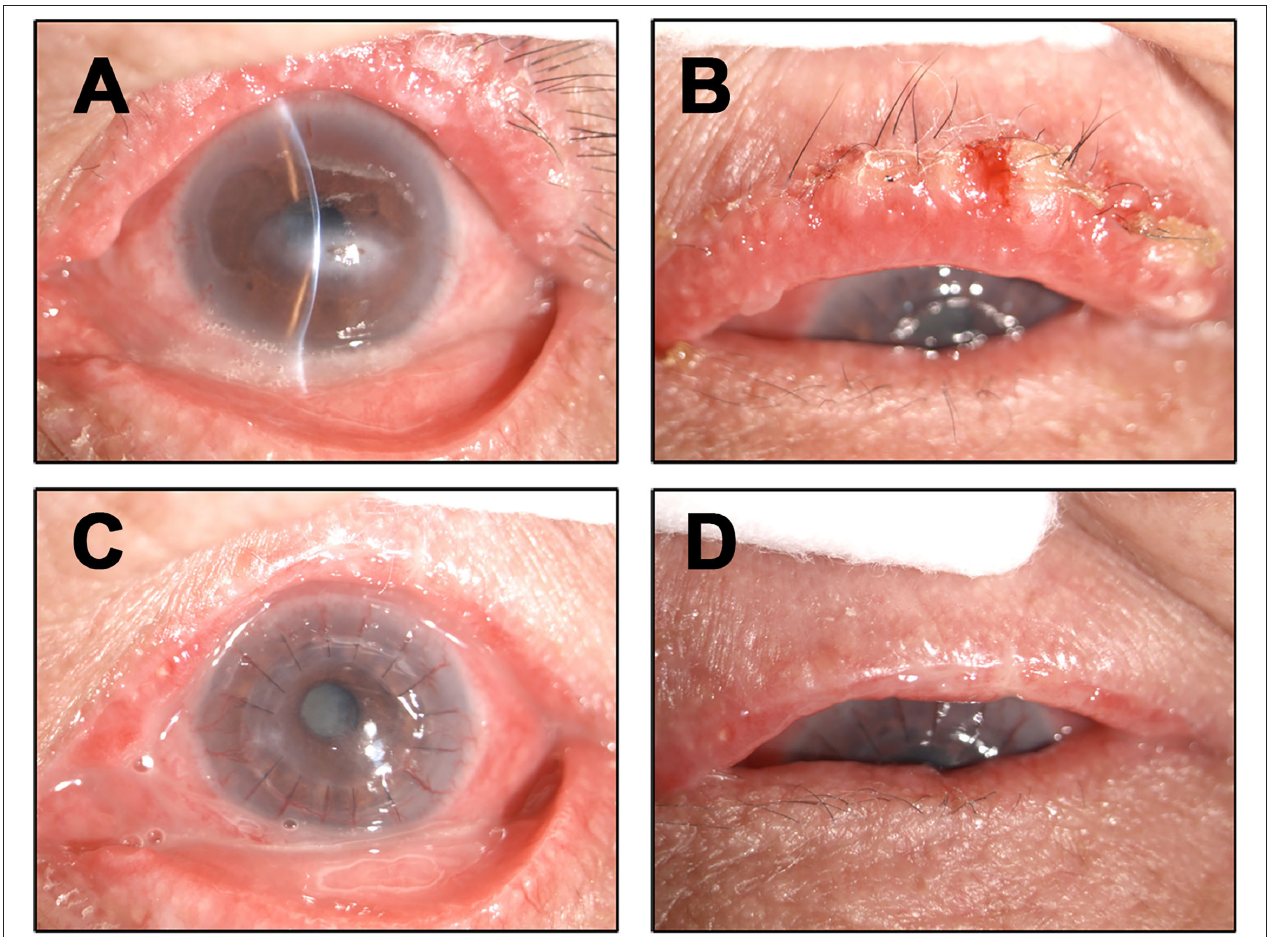
FIGURE 1 | Ocular surface findings. (A) Clinical photographs at the first visit. The left upper eyelid had slight keratinization, several aberrant lashes with clogged meibomian gland, conjunctival was congestions corneal epithelial punctate defect, perforation. (B) During the second month review after penetrating keratoplasty the patient presenting with small nodules accompanied with bleeding, burst and madarosis in the left eyelid margin. (C,D) During 1 year followup the corneal graft was transparent and the eyelid margin did not show any TLC recurrence and